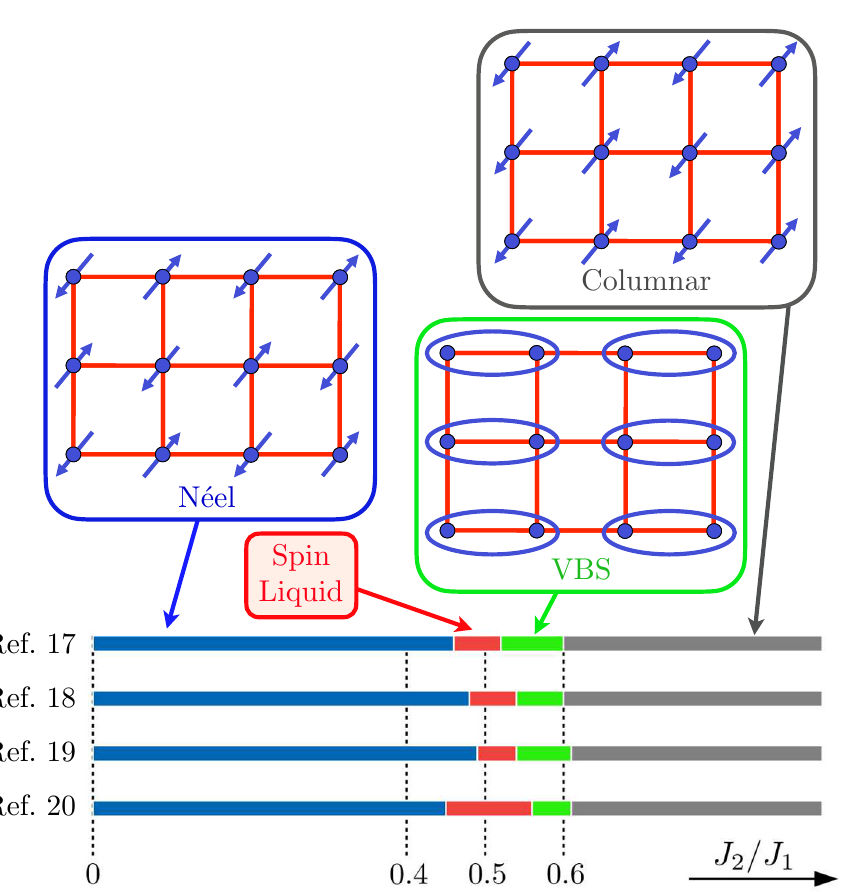
Figure 1 . Phases of the S = 1 / 2 J 1 - J 2 antiferromagnet on the square lattice, from the numerical results of refs. [17–20], all of which agree that the spin liquid is gapless. Each ellipse in the valence bond solid (VBS) represents a singlet pair of electrons. Lower part of figure adapted from ref.